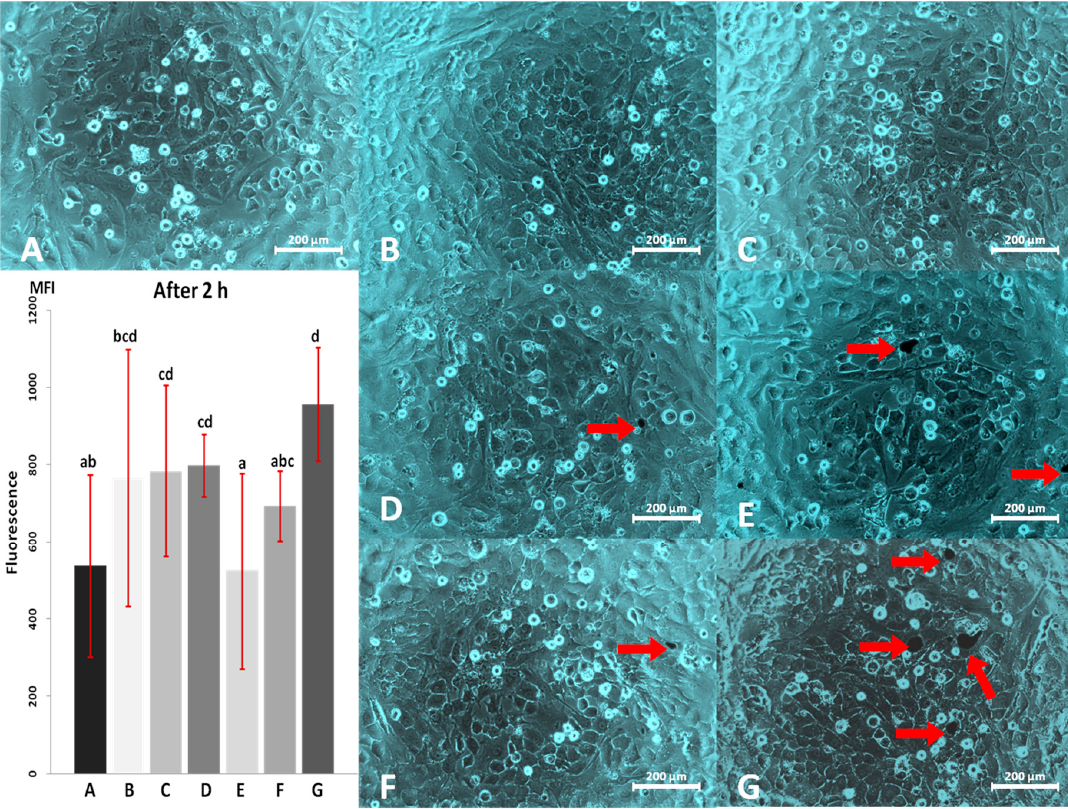
Figure 3. Cardiac progenitor cell morphology and viability after 2 h of culture with AgNP and HNC; ( A ) control culture; ( B ) culture with 2 μ g/mL AgNP; ( C ) culture with 10 μ g/mL AgNP; ( D ) culture with 0.4 μ g/mL HNC; ( E ) culture with 2 μ g/mL HNC; ( F ) culture with 2 μ g/mL AgNP and 0.4 μ g/mL HNC; ( G ) culture with 10 μ g/mL AgNP and 2 μ g/mL HNC. ( A – G ) Series of viability in individual experimental groups measured as fluorescence. (a–d) Statistically significant differences ( p ≤ 0.05). Arrows indicate agglomerates of HNC. Magnification 100×. Scale bars 200 μ m. MFI—mean fluorescence intensity.